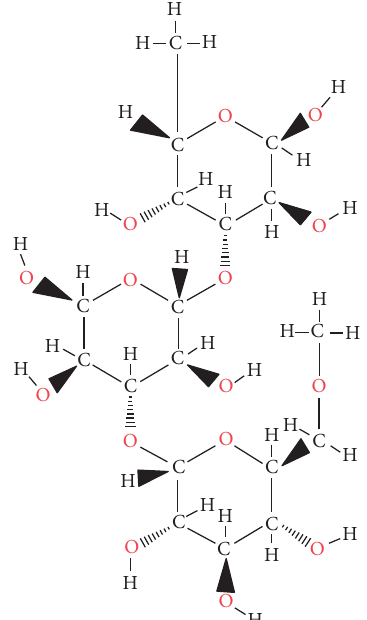
Figure 1: Pullulan chemical structure with repeated maltofructose